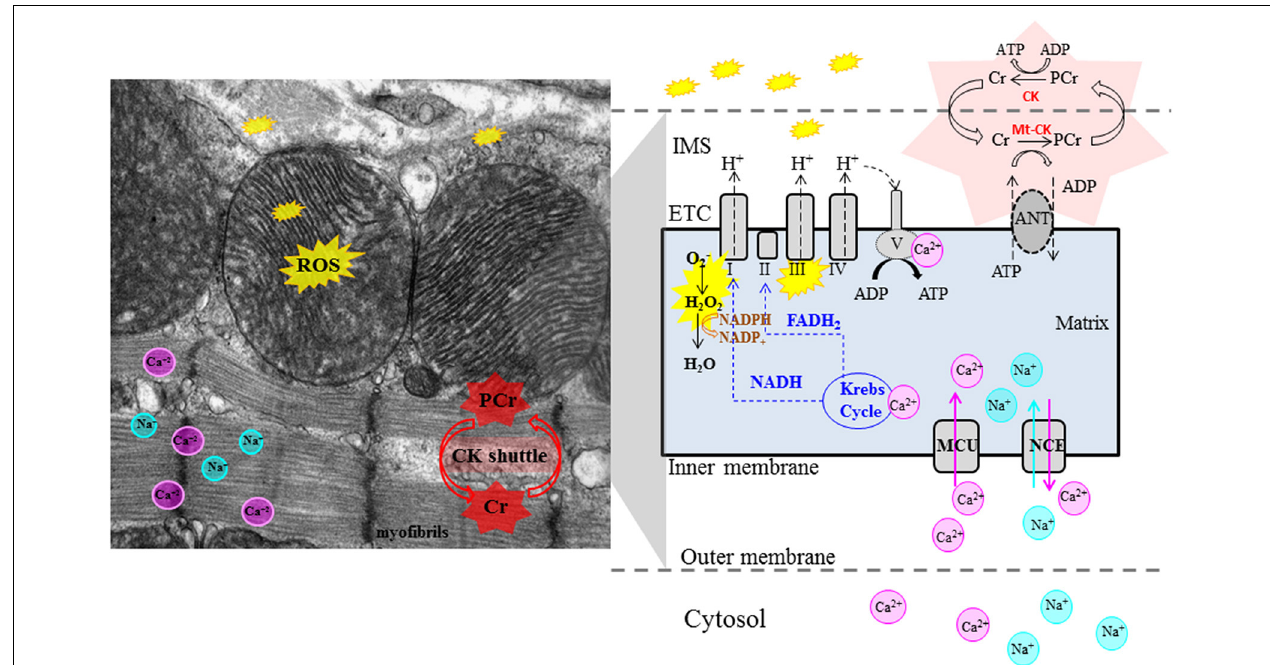
FIGURE 2 | Role of Mitochondria in pathogenesis of cardiac phenotype in HCM. Left panel: electron microscopy image of mouse heart. Right panel: schematic illustrating mitochondrial physiology. The Krebs cycle generates reducing equivalents (NADH, FADH 2 ) that drive proton pumping, establish the proton-motive force across the mitochondrial inner membrane and contribute to ROS scavenging. Mitochondrial ATP synthase (complex V) couples proton influx to ATP generation. Matrix concentrations of Ca 2 + and Na + play an important role in control of oxidative phosphorylation.